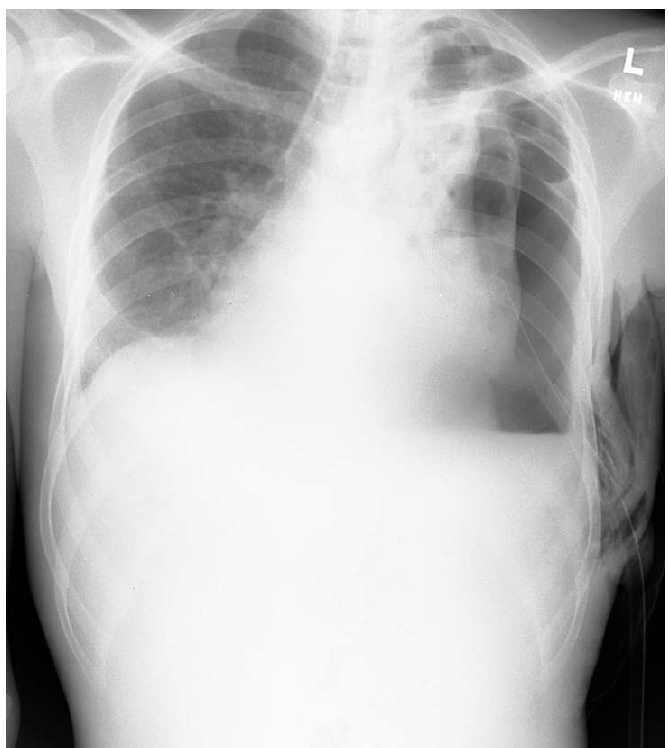
Figure 1. Chest radiograph after tube thoracostomy of a 32-year- old male with shortness of breath, with improvement in respiratory status and lung expansion with persistent left-sided air-fluid level and pneumothorax. (All patient images taken with permission of patient or accompanying